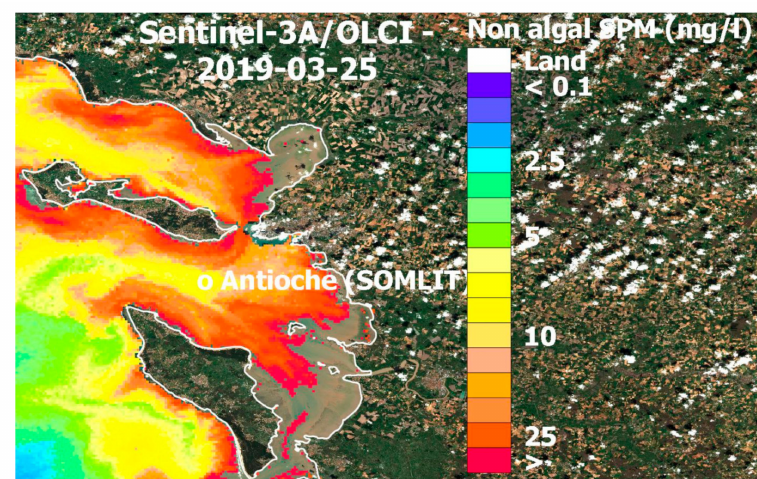
Figure 14. Non-algal SPM derived from OLCI-A at Antioche on 25 March 2019 at 12h10 UT (Low Tide at 12h47) Foreshore in